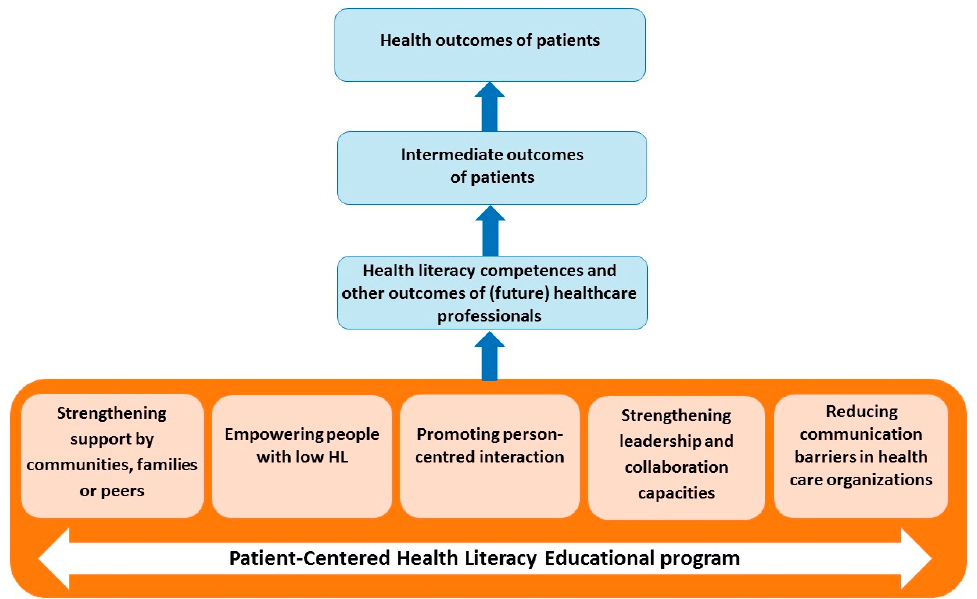
Figure 1. Comprehensive health literacy educational framework promoting person-centred care.